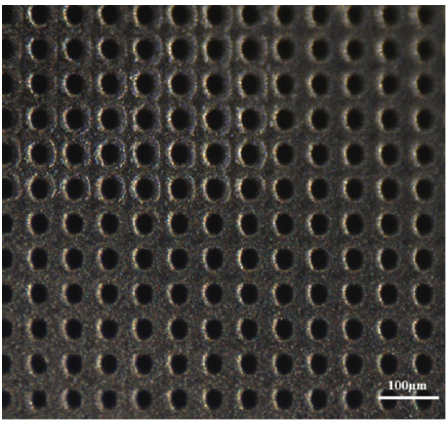
Figure 3. Gold-coated CKC membrane before being functionalized and used for viability tests (migration side).